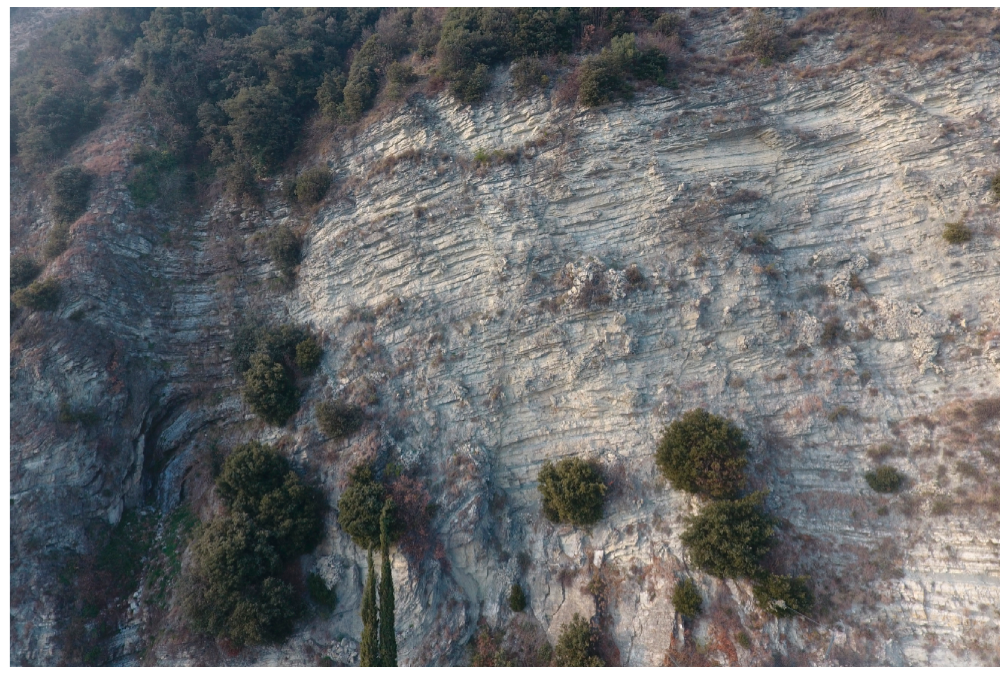
Figure 2. Rock face along the Gardesana Road (Italy).